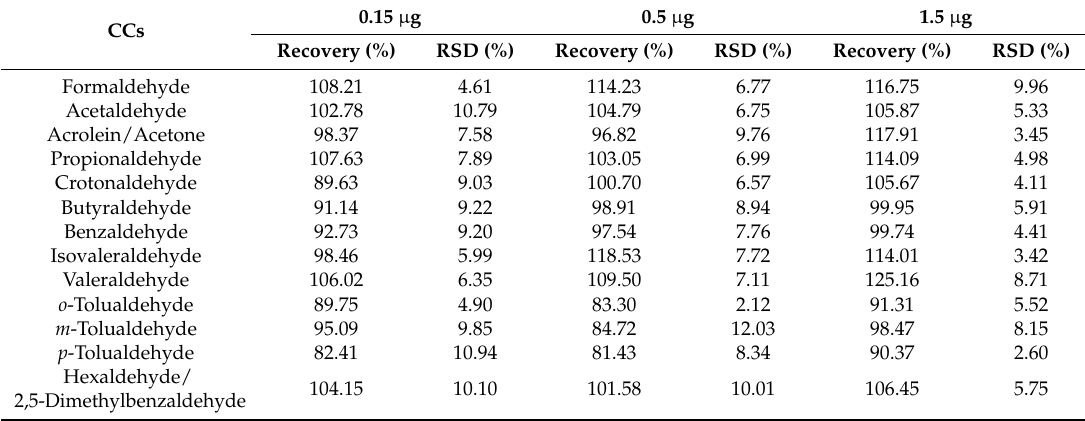
Table 4. The recovery for